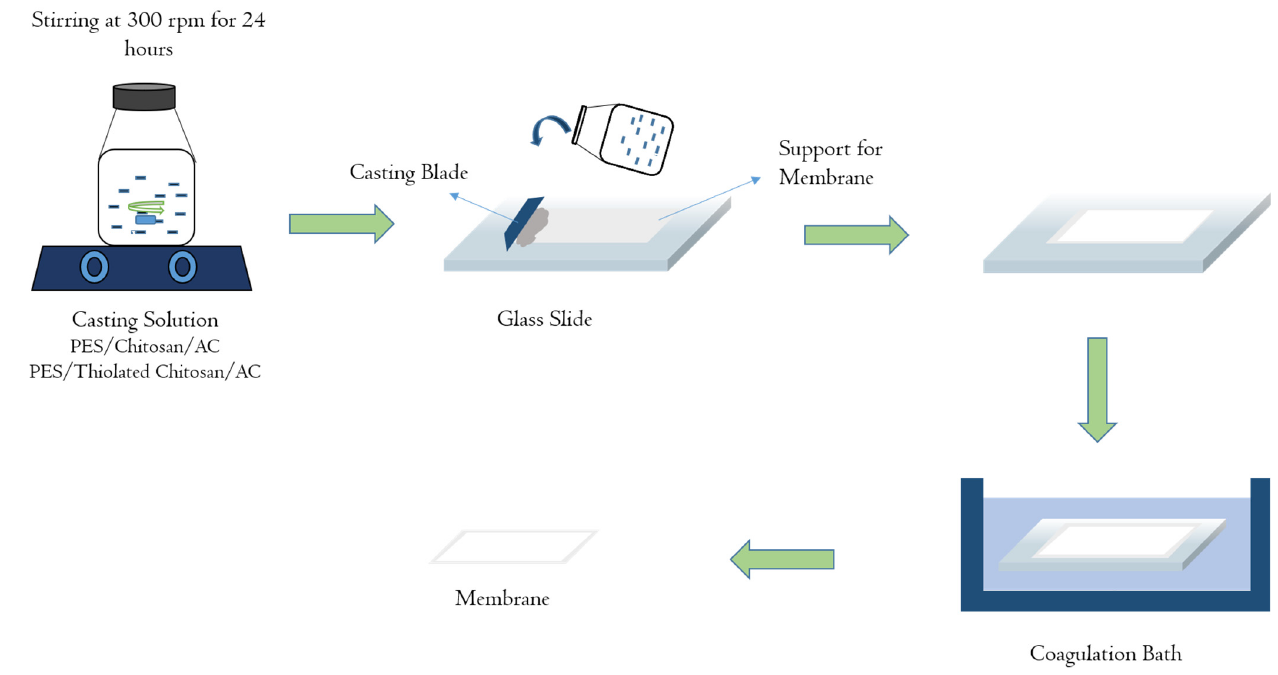
Figure 1. Schematic for the membrane fabrication process (phase inversion).